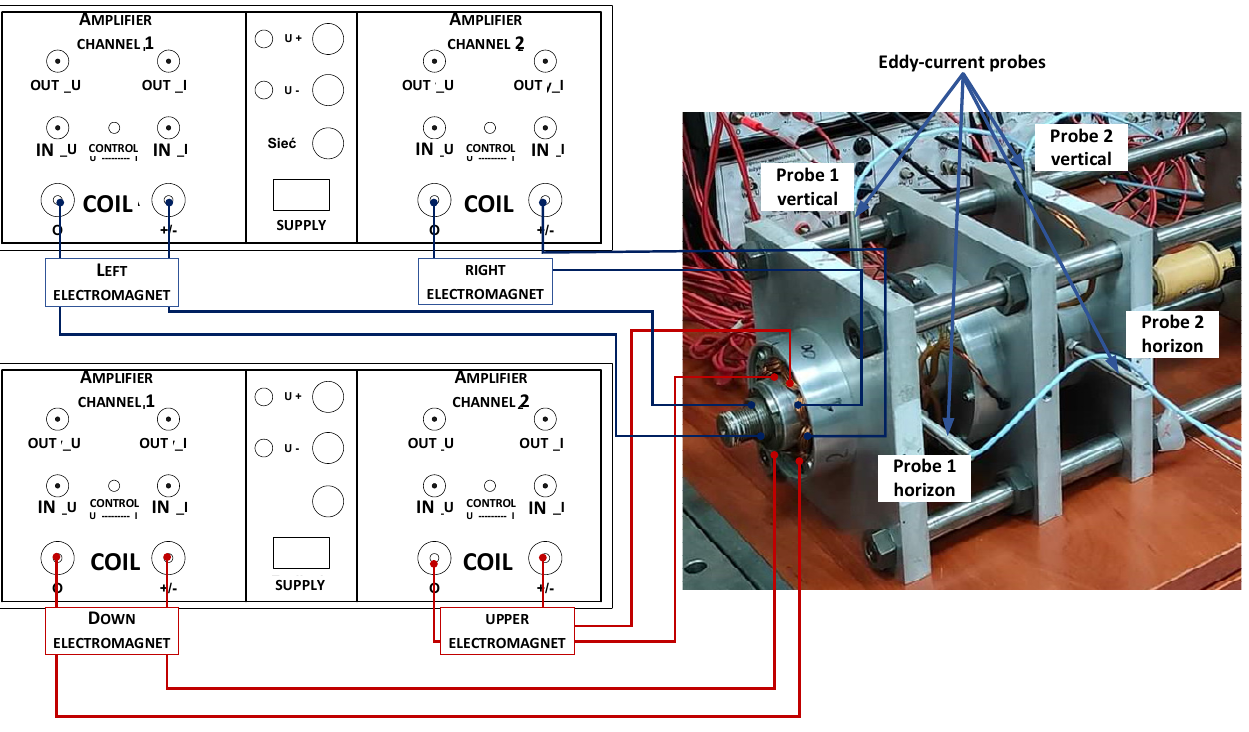
Figure 6. Configuration of test rig for left magnetic bearing.